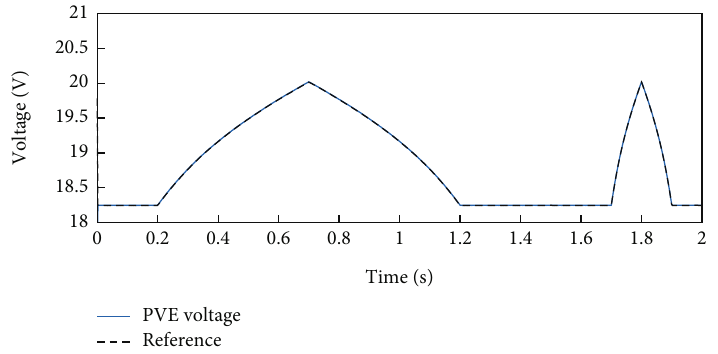
Figure 18: Response of the PVE to the EN 50530 irradiance (voltage).